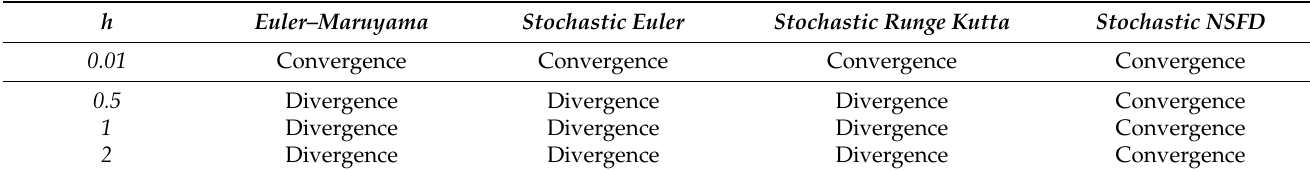
Table 3. Comparison of numerical techniques for different step sizes ‘h .